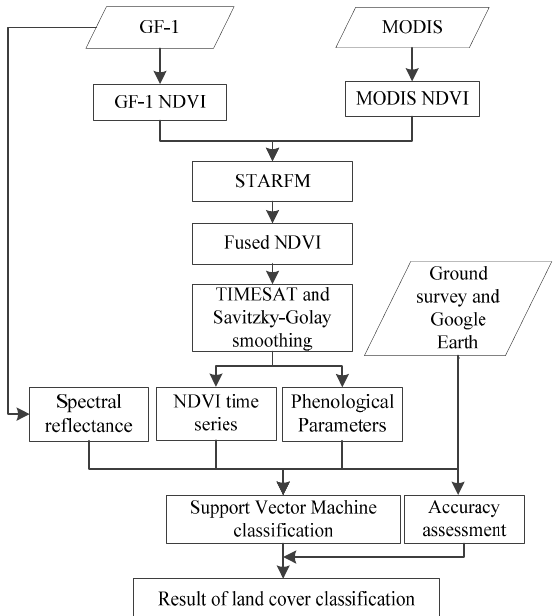
Figure 2. Flowchart of the land cover classification process based on fusion of GF-1 and MODIS NDVI time-series data.